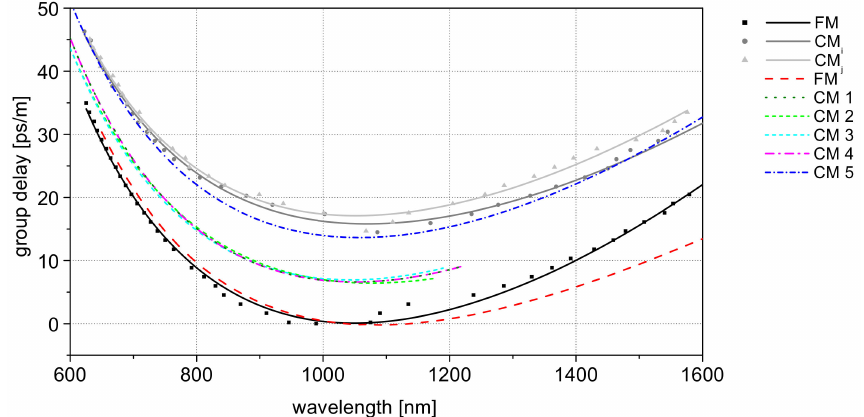
Figure 4. Measured (markers), fitted (solid) and calculated (dashed lines) curves of the group delay in the ESF for a 0.461 m length of the fiber. FM, fundamental mode and CMi, arbitrarily labeled cladding